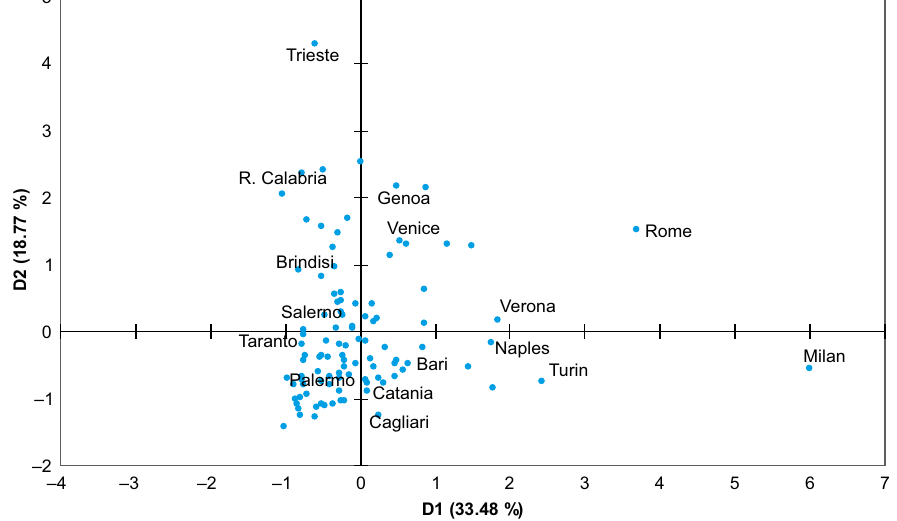
Fig. 2. Factor scores of NUTS3